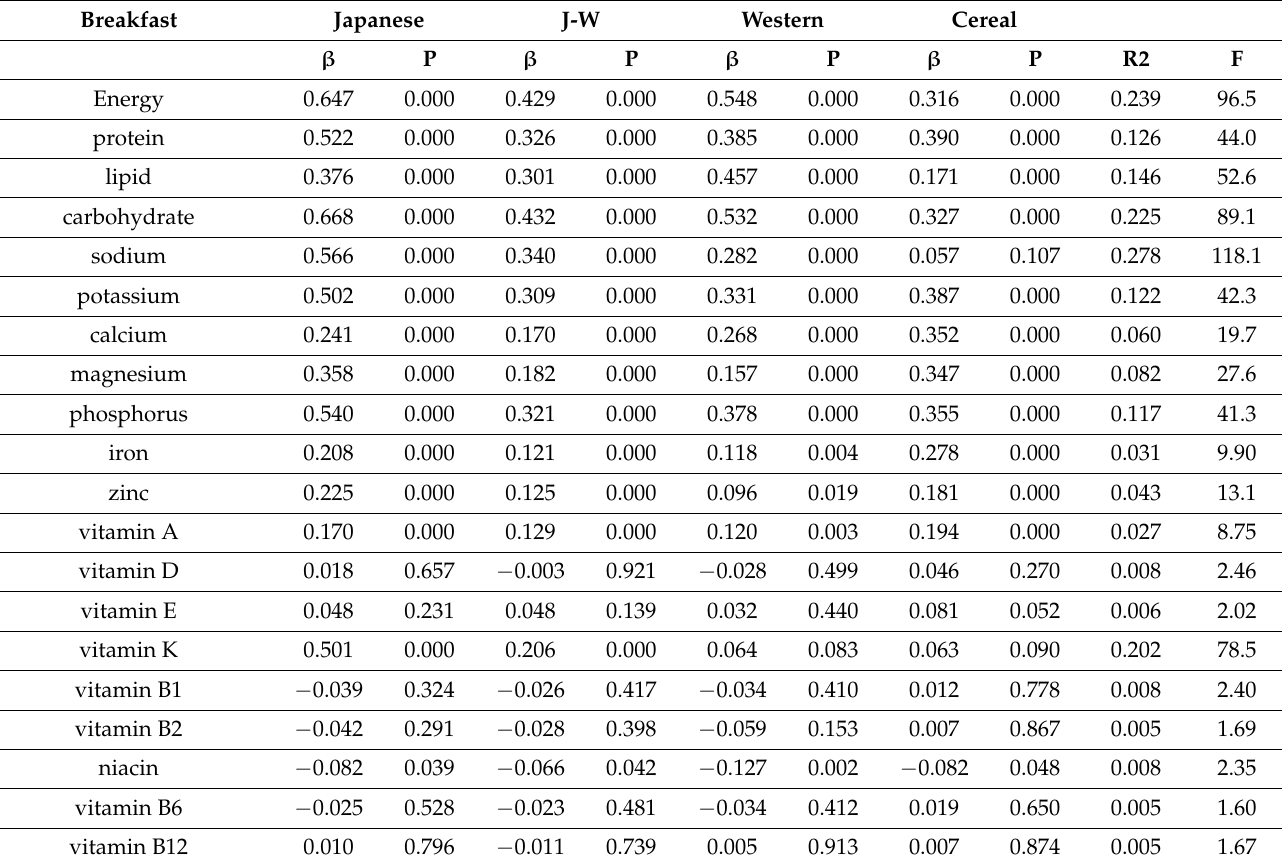
Table 4. Multivariate linear regression analysis for interaction between breakfast meal style and nutrients at